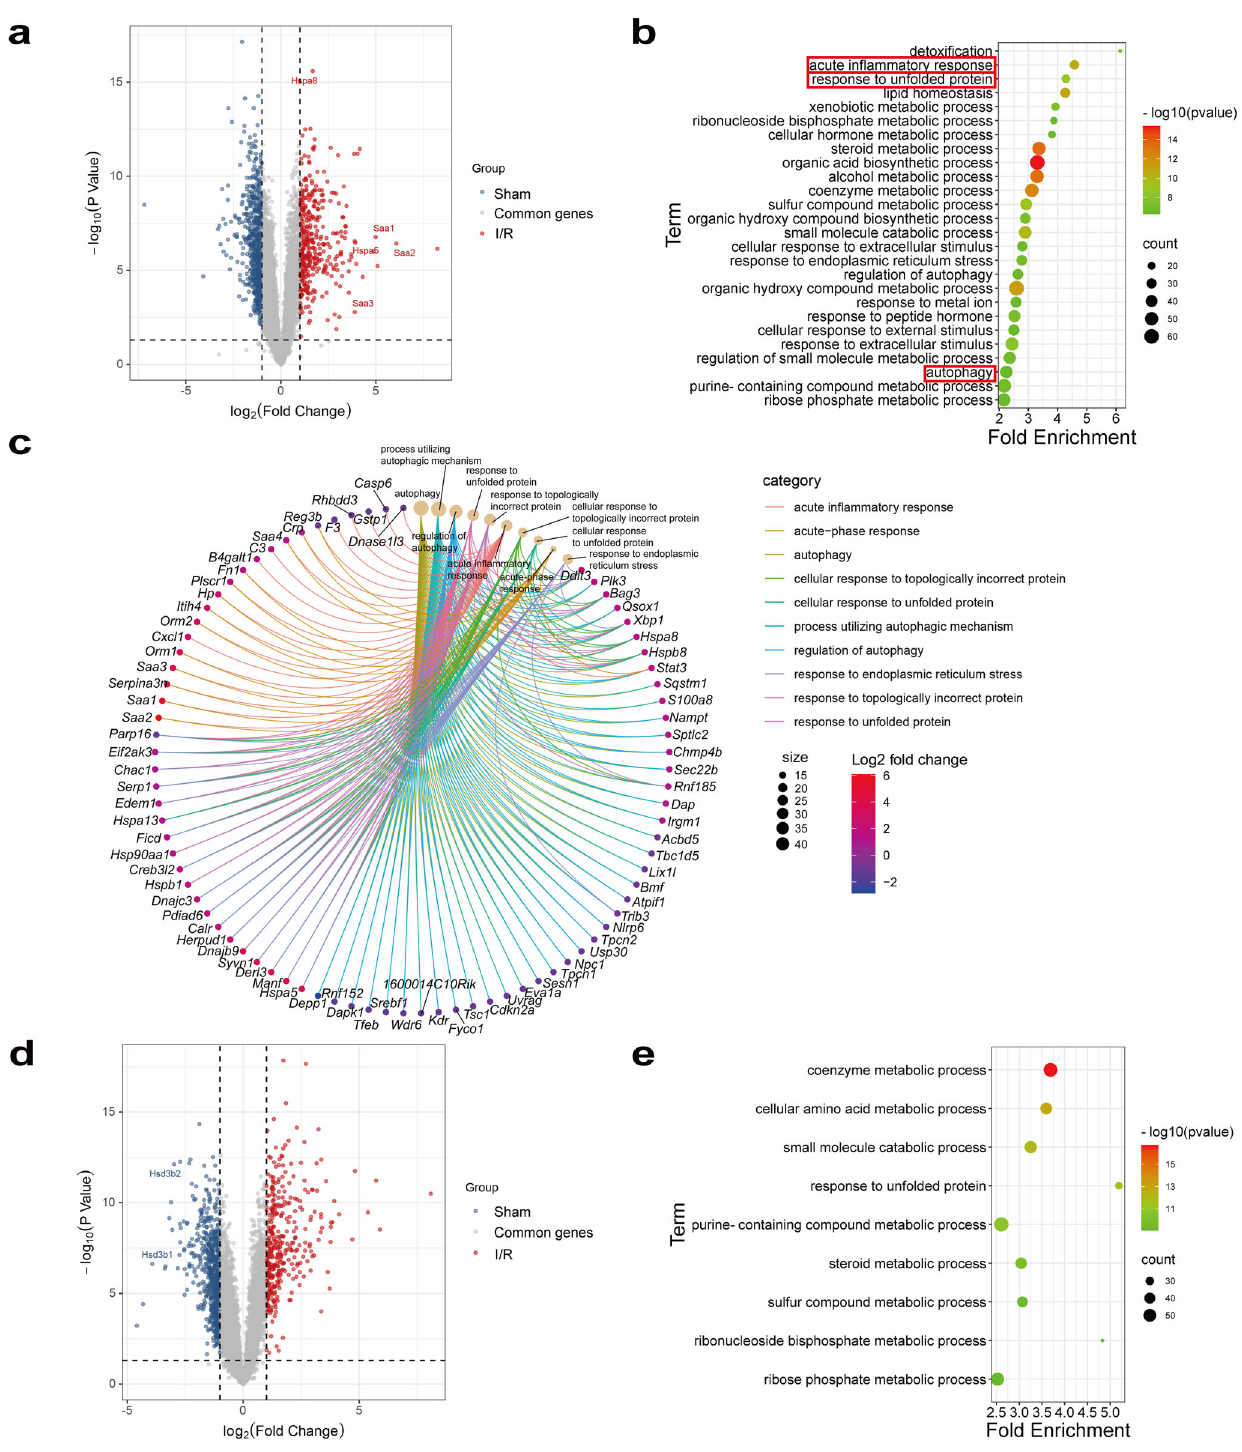
Fig. 3 Post-I/R zone-speci fi c DEGs and functional pathways. a , b Volcano plot and GO analysis of zone 3-speci fi c DEGs of sham and I/R group. c Cnet plot of I/R-induced and zone 3-speci fi c DEGs associated with “ acute in fl ammatory response ” , “ response to unfolded protein ” , and “ autophagy ” pathways. d , e Volcano plot and GO analysis of zone 1-speci fi c DEGs of sham and I/R